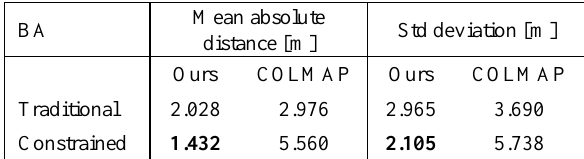
Table 4 . Statistics of dense reconstruction accuracy for the uncalibrated multi-camera systems in overlapping case (Experiment II). COLMAP implements the constrained BA solution using the rig_bundle_adjuster